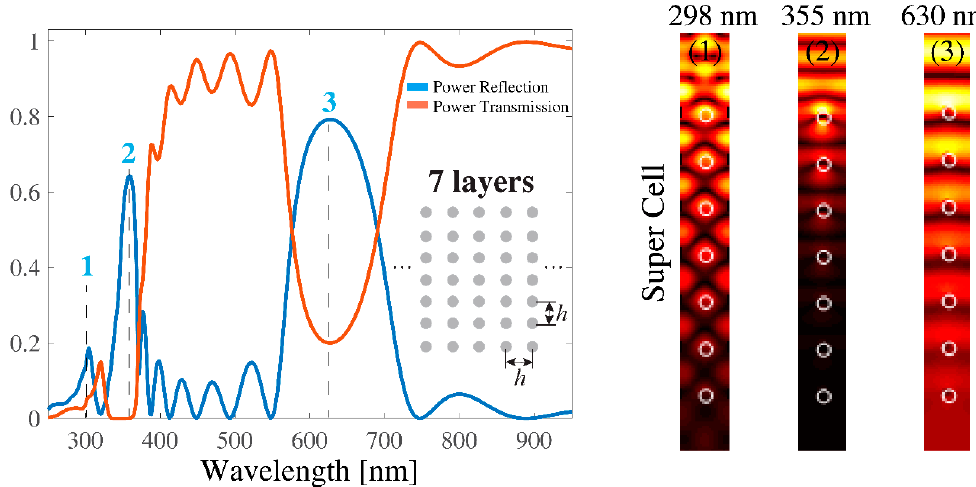
Figure 4. ( left ) Spectral response of the power reflection/transmission for the same configuration in Figure 1, but for seven layers along the y -axis. ( right ) Near field | H z | distributions at three different peak wavelengths, i.e. 298 nm (associated with the Rayleigh wavelength), 355 nm (associated with a resonance wavelength of a single silver nanocylinder), and 630 nm (associated with plasmonic gap in Figure 1).